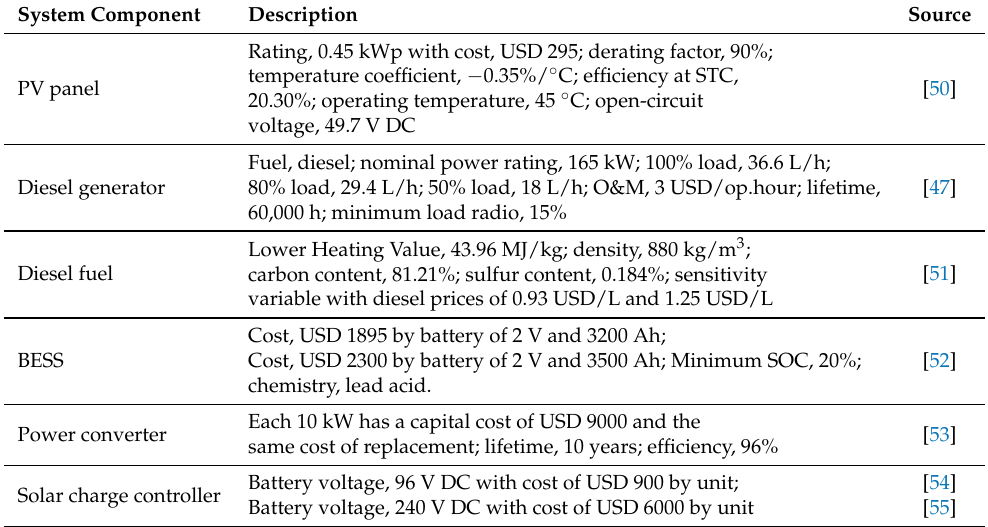
Table 3. Characteristics of the components used in the proposed power